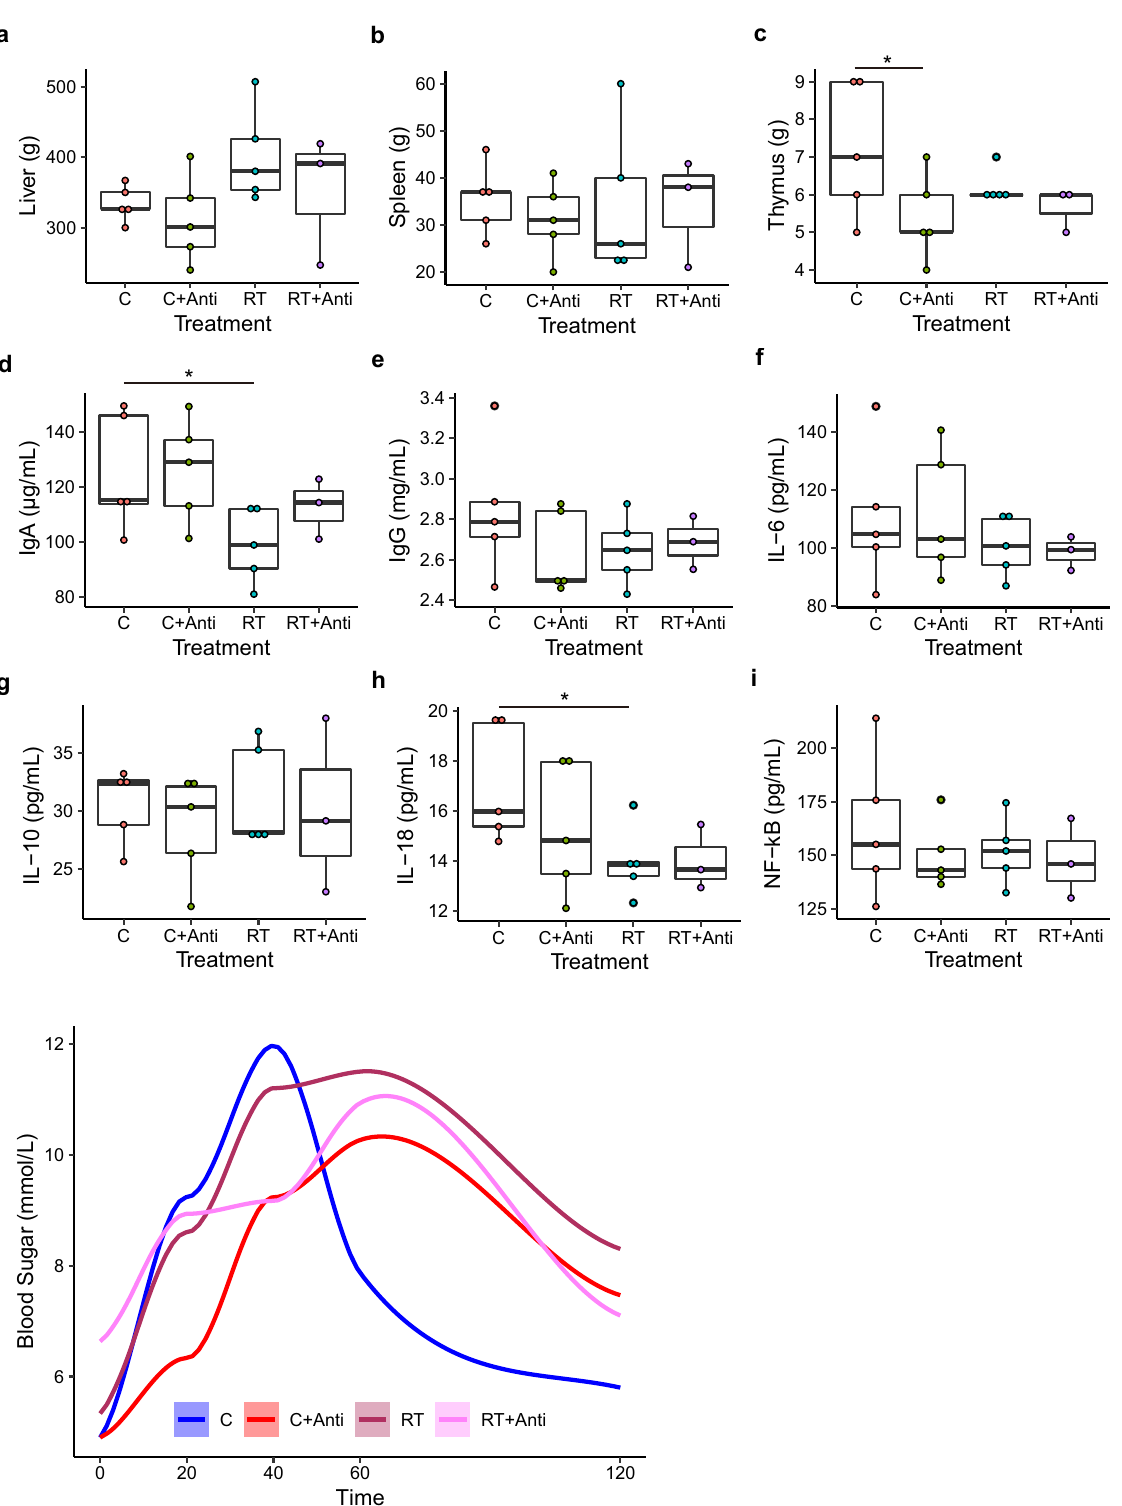
Fig. 2 Effects of cold stress on the weight of organs, immune factors, and cytokines in serum and glucose tolerance tests. a Liver weight. b Spleen weight. c Thymus weight. d IgA level in serum. e IgG level in serum. f IL-6 level in serum. g IL-10 level in serum. h IL-18 level in serum. i NF − kB level in serum. j Glucose tolerance test. The data are the means ± SEMs ( n = 3 or 5 per group). Statistical signi fi cance was determined using Wilcoxon test (* p < 0.05, ** p < 0.01, *** p <